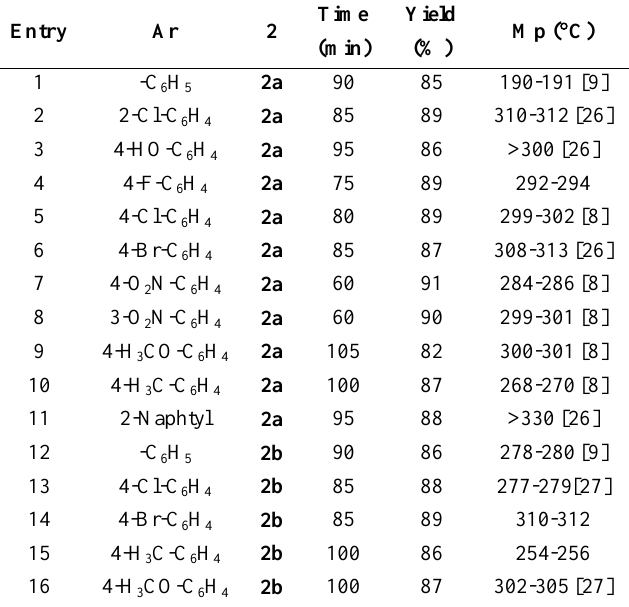
Table 2. Synthesis of 1,8-dioxodecahydroacridines (4) by nano TiO as a reusable catalyst a 2